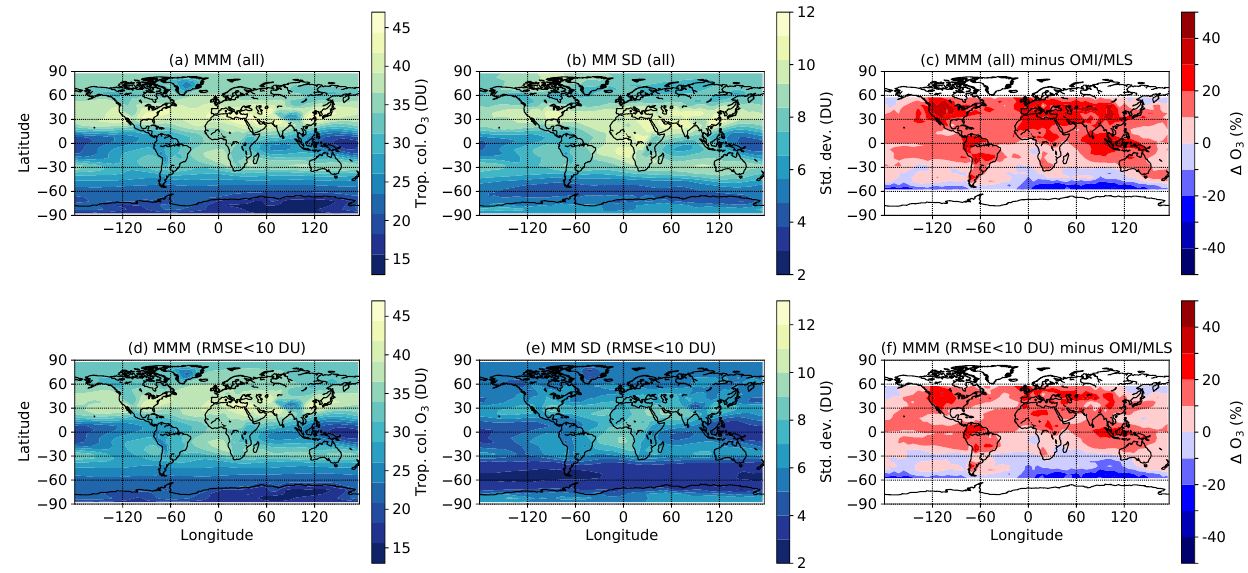
Figure 8. Annual-mean year 2005 tropospheric column ozone. (a) The multi-model mean (MMM) of all CCMI models; (b) multi-model standard deviation for the models shown in (a) ; (c) percent difference between the MMM in (a) and OMI/MLS (MMM minus OMI/MLS); (d) MMM for a subset of CCMI models – those with a root-mean-square error (RMSE) less than 10DU when compared with OMI (see Fig. 7); (e) multi-model standard deviation for the models shown in (d) ; (f) percent difference between the MMM in (d) and OMI/MLS (MMM minus